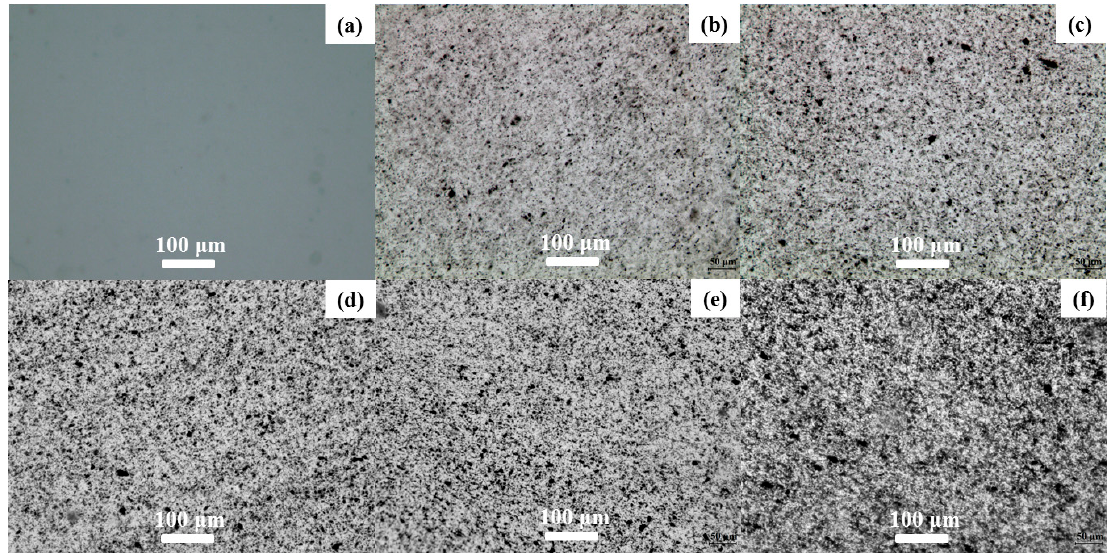
Figure 3. Optical micrographs of ( a ) PP and PP/EMoS 2 nanocomposites with different EMoS 2 contents: ( b ) 0.4 wt %; ( c ) 0.7 wt %; ( d ) 1.1 wt %; ( e ) 1.7 wt %; and ( f ) 2.1 wt %.